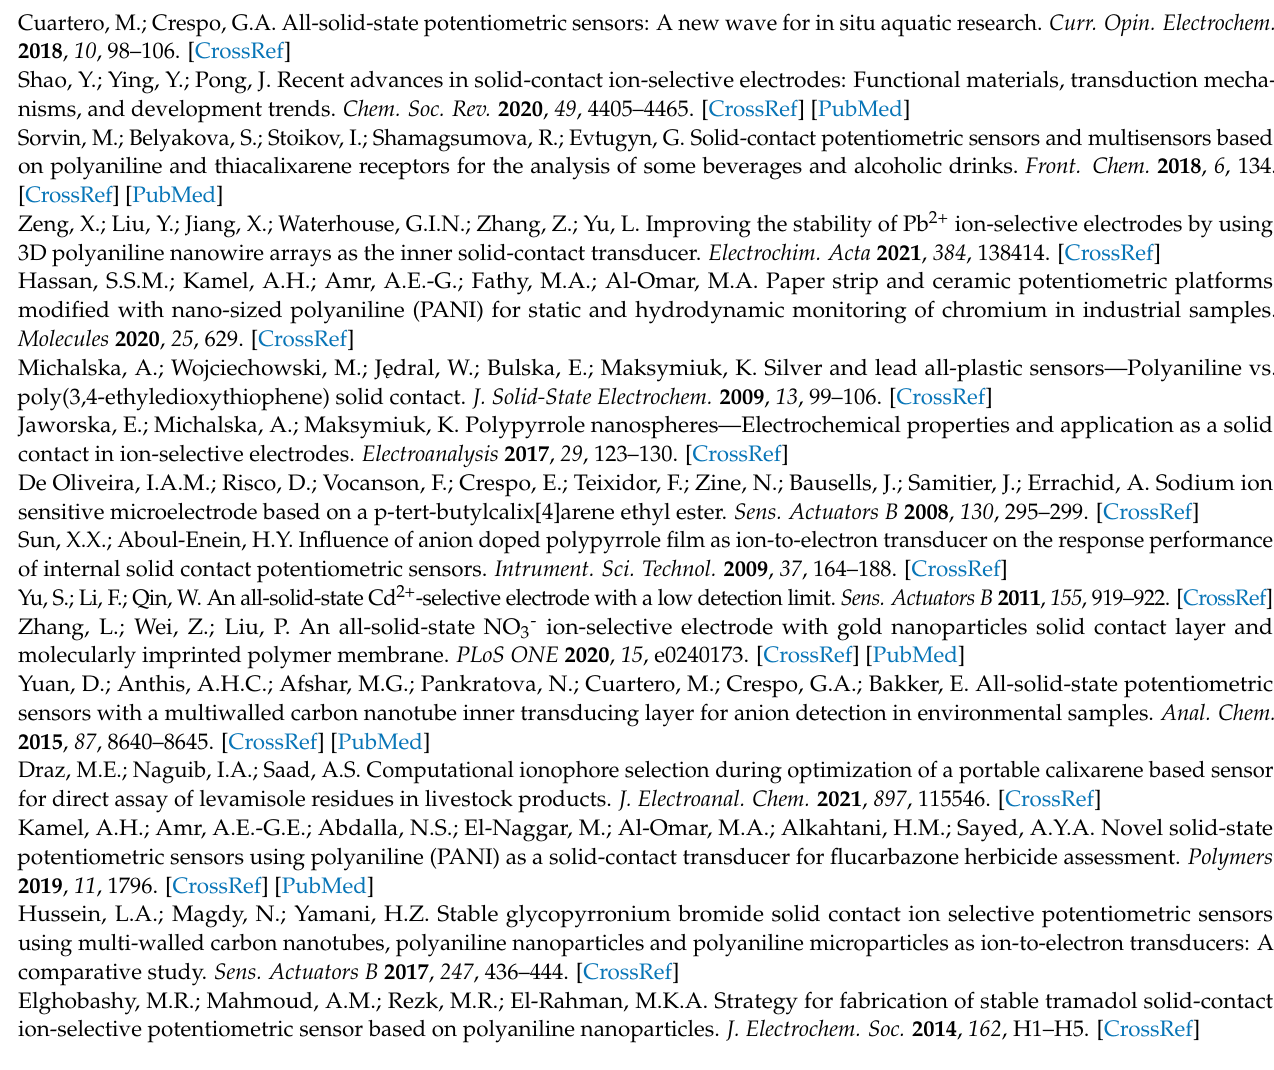
Table S1—concentrations of CuCl2 solution used for dynamic response assessment (legend to Figure